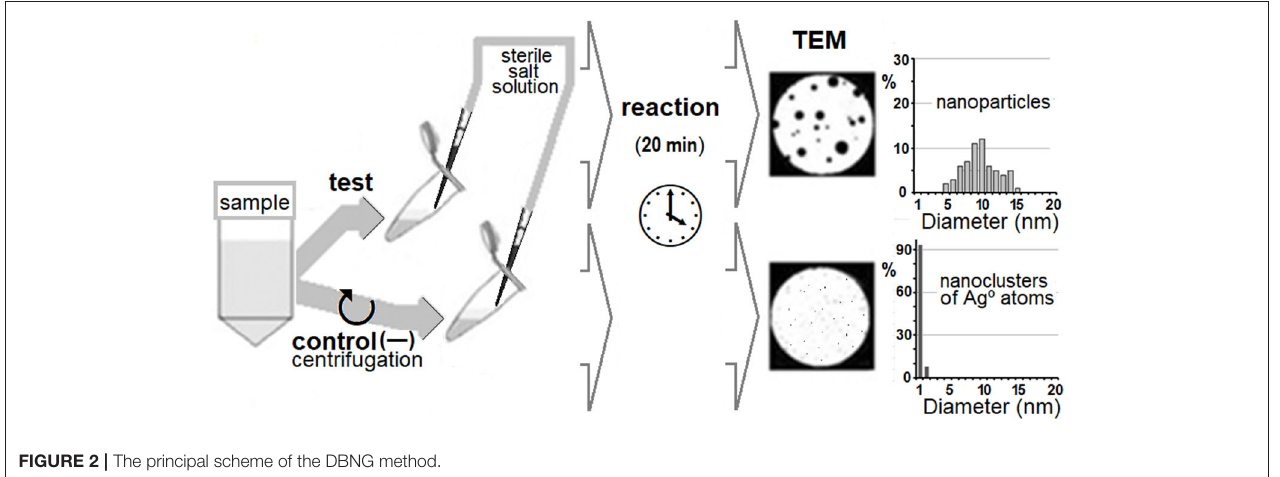
FIGURE 2 | The principal scheme of the DBNG method.